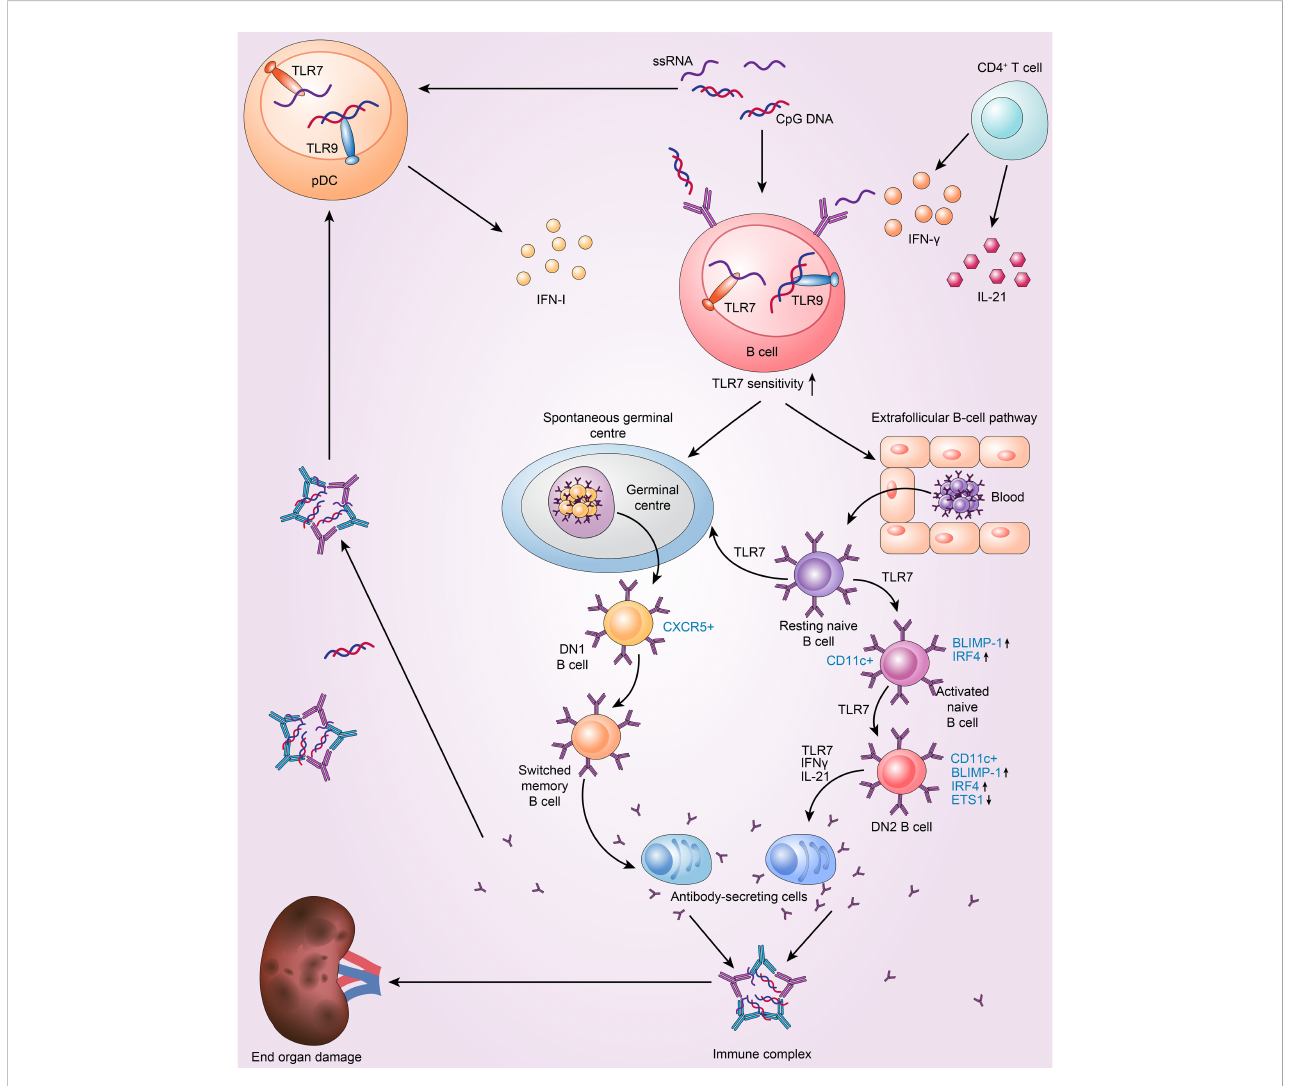
FIGURE 1 TLR7 drives the extrafollicular B-cell response and the loss of germinal centre (GC) tolerance, which is implicated in the pathogenesis of SLE. 1. Resting naive B cells enter the germinal centre pathway, which generates DN1 B cells and memory B cells, and then differentiate into antibody-secreting cells. The above processes are dependent on TLR7. 2. TLR7 drives the extrafollicular pathway, in which resting naive B cells successively become activated naive B cells, DN2 subset B cells and fi nally antibody-secreting cells. 3. pDC and T cells intensify TLR7 sensitivity to drive autoreactive B-cell development into antibody-secreting cells by secreting IFN-I, IFN- g and